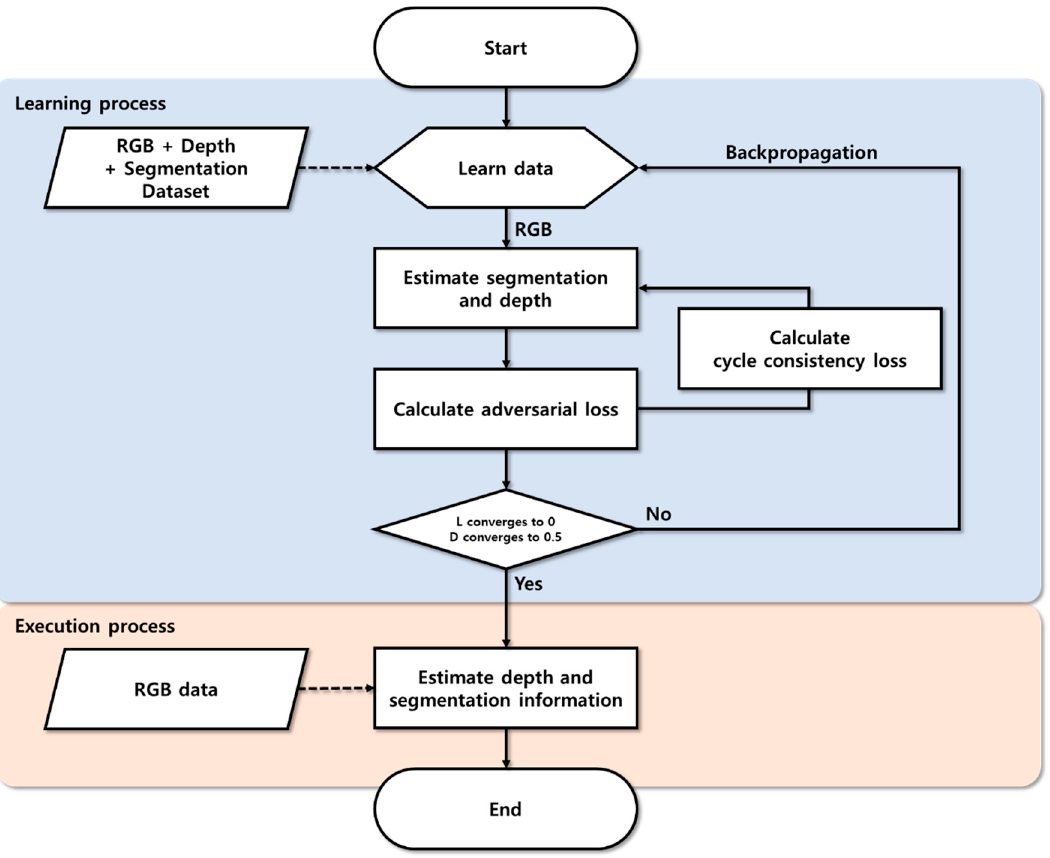
Figure 5. Flowchart for depth estimation method using cycle GAN.